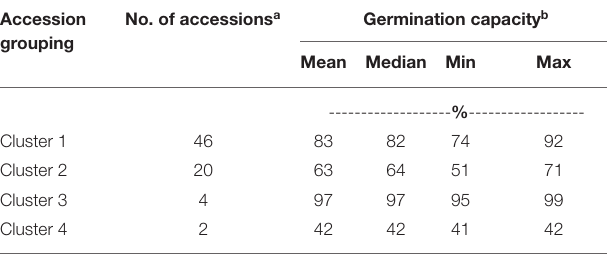
FIGURE 4 | Castellation plot showing four clusters of E. colona from Arkansas, USA based on germination capacity. The accessions were grown in a common garden in Fayetteville, Arkansas. Seeds were after-ripened for 180 d at 25 ◦ C and germinated in a growth chamber at 32 ◦ C day/23 ◦ C night temperature with 12-h photoperiod. Cluster 1 = blue; Cluster 2 = red; cluster 3 = brown, Cluster 4 = green. TABLE 5 | Germination capacity of Echinochloa colona from Arkansas, USA, averaged across accessions in a cluster.